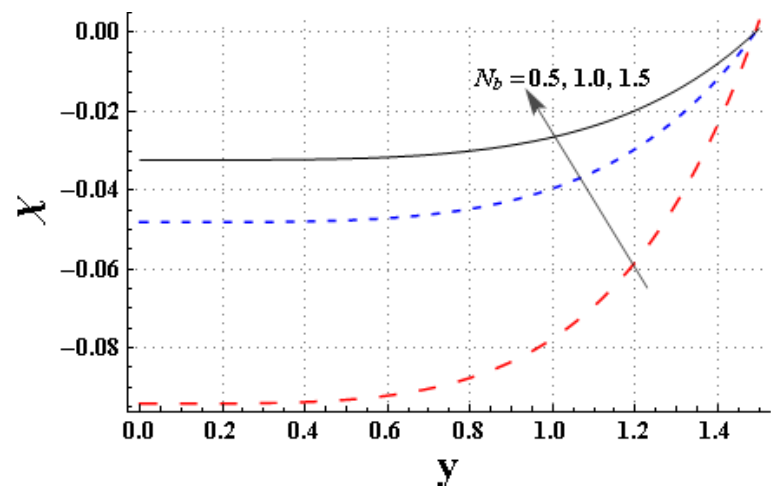
Figure 20. Effect of the thermophoresis number, t isms, .